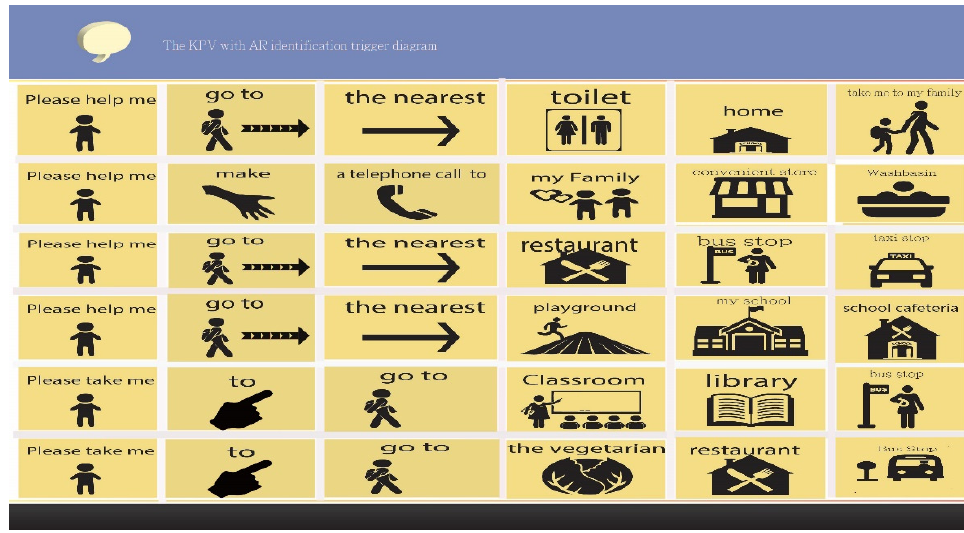
Figure 2. Ten scene videos and trigger definitions.